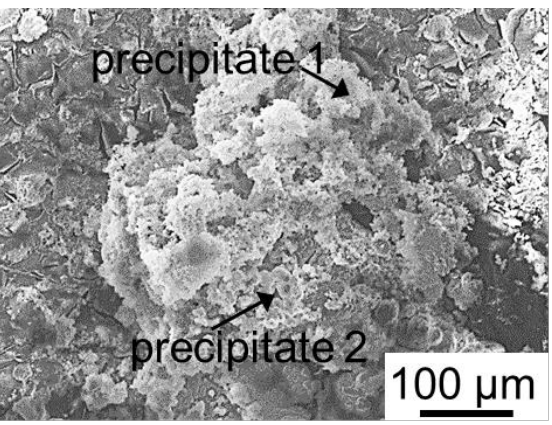
Figure 9. SEM images of the MC-40 cation exchange membrane surface facing the desalination compartment after ED demineralization of a multicomponent solution in CC1 mode .